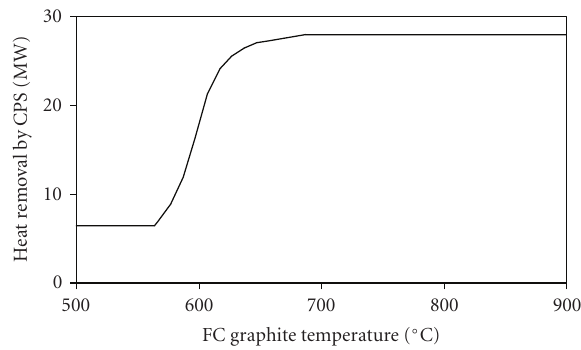
Figure 17: Dependency of removed heat capacity on the temper- ature of FCs graphite column, when regular CPS cooling circuit is available.